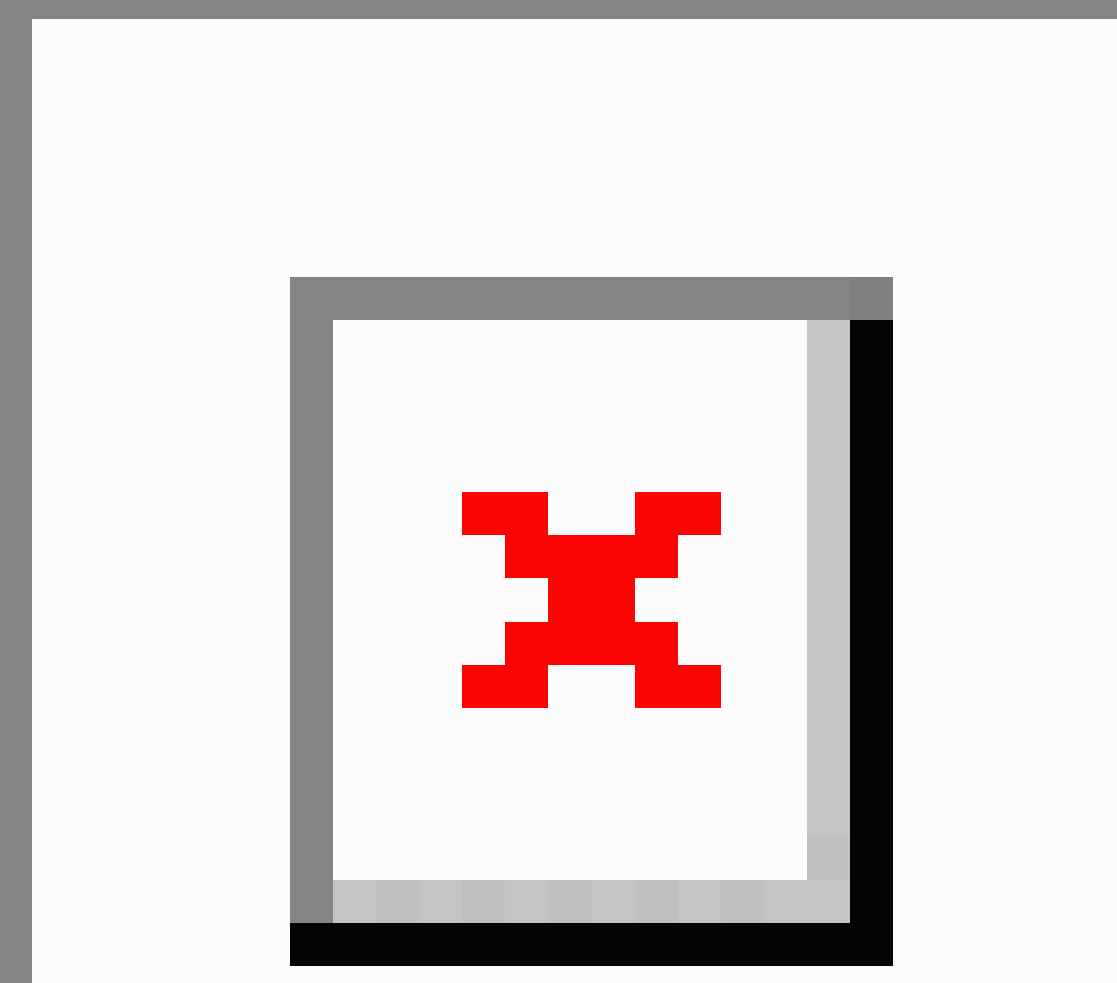
Figure 8. Webpage dashboard example summarizing research assistant interview performance for a baseline interview conducted in September